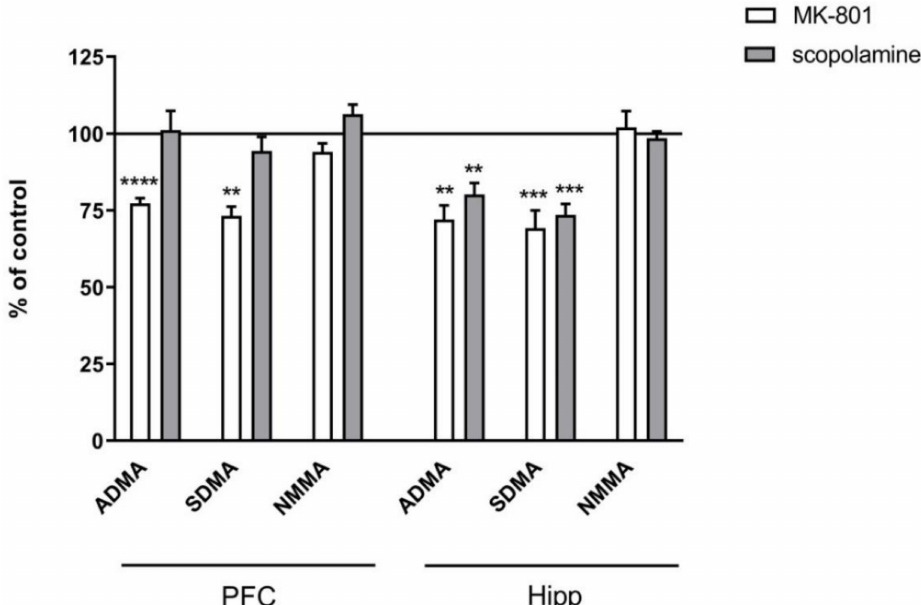
Figure 9. ADMA, SDMA and NMMA levels in the prefrontal cortex (PFC) and hippocampus (Hipp) after chronic (14 days) administration of MK-801 (0.3 mg/kg) or scopolamine (1 mg/kg). Data are presented as means ± SEM. ** p < 0.01; *** p < 0.001; **** p < 0.0001 vs.